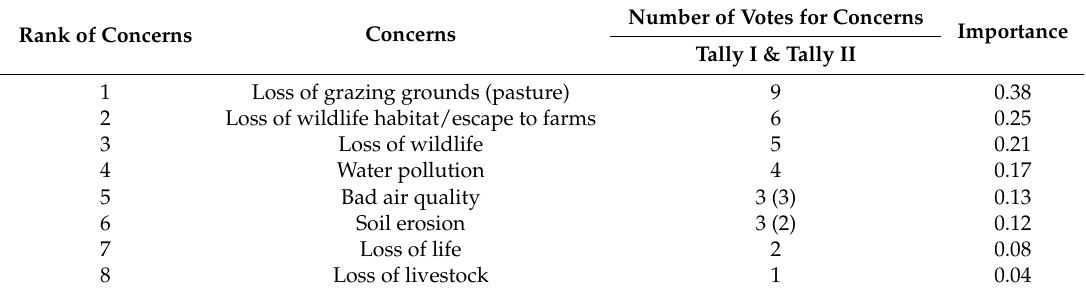
Table 2. The votes and rank of concerns related to fire effects in Gathiuru Forest (N = 24). Rank of Concerns